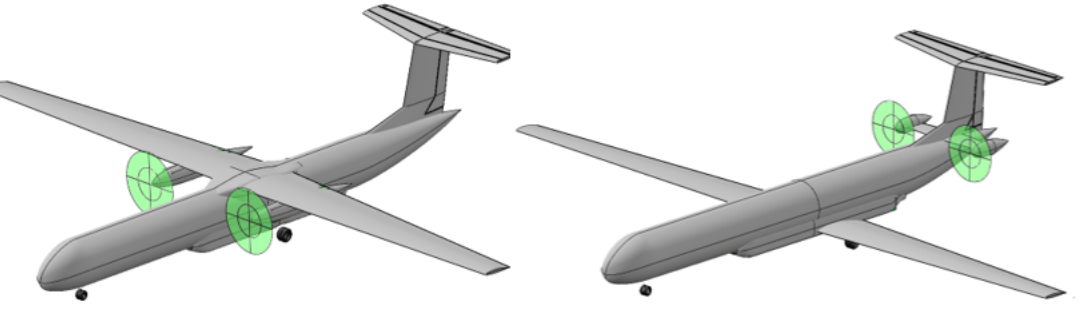
Figure 9. OpenVSP models of two configurations for the